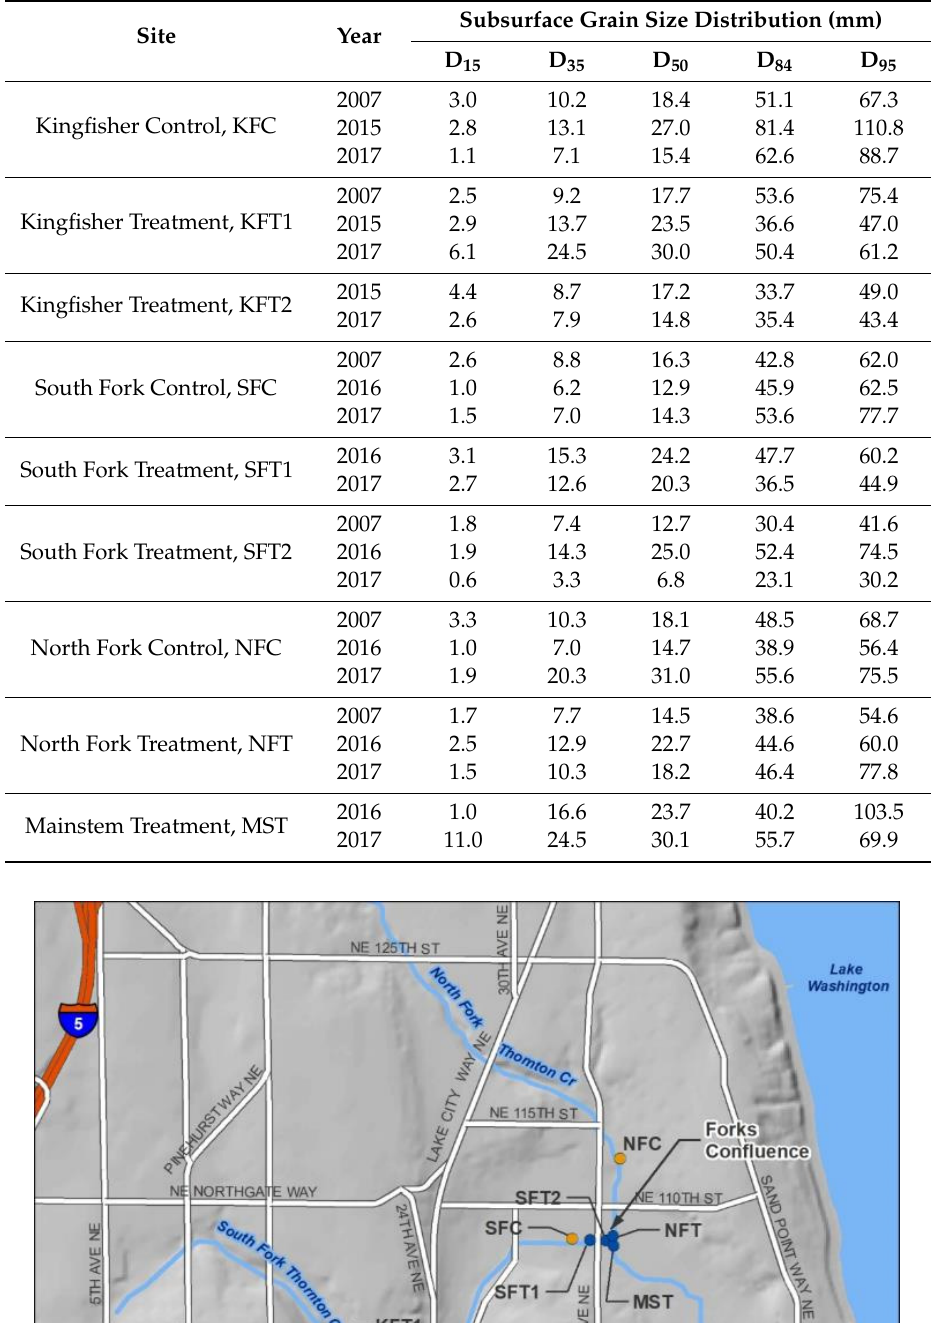
Table A2. Streambed subsurface layer grain size statistics for all 9 Thornton Creek sites (see Figure A1).